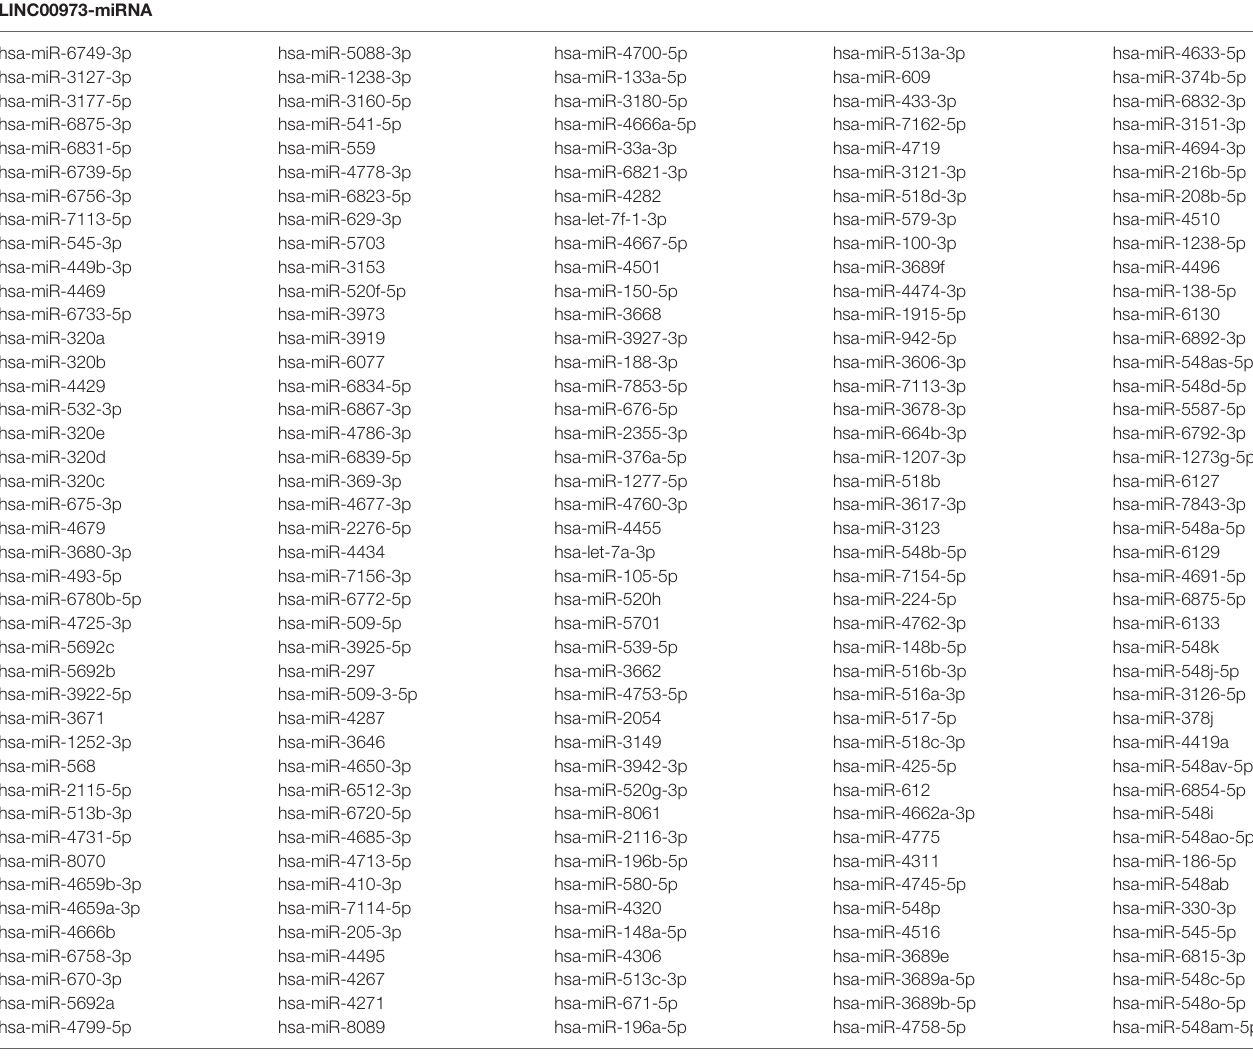
TABLE 1 | LINC00973-bound miRNA in the LncBase Predicted v.2 database. LINC00973-miRNA